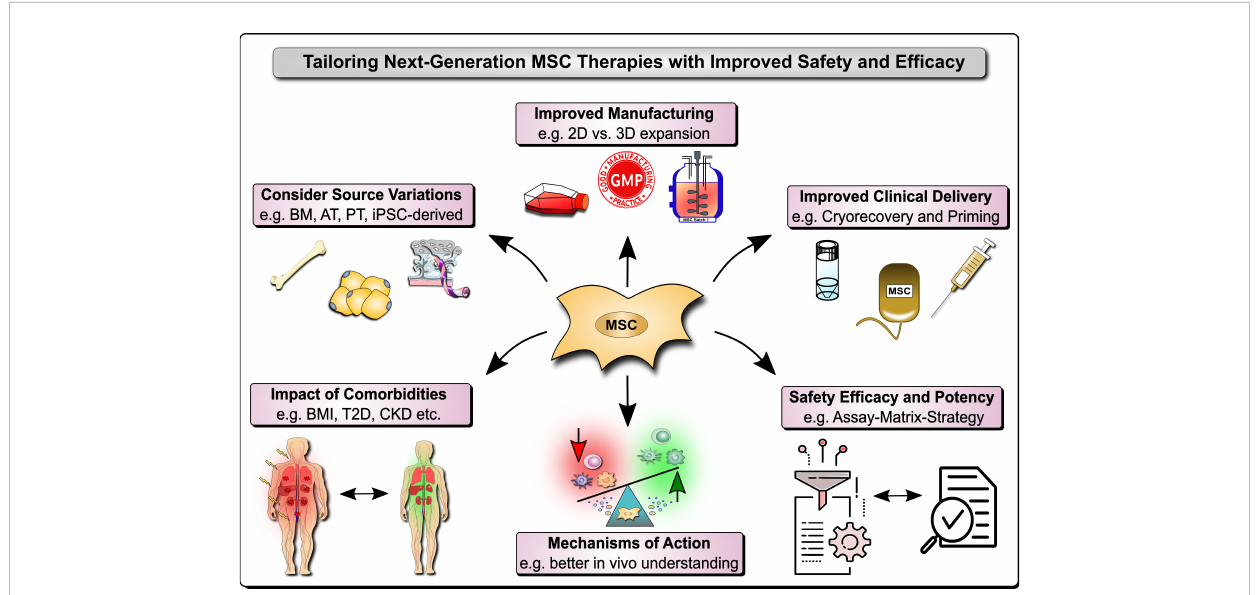
FIGURE 1 Next Generation MSC Therapy Manufacturing, MoA and Potency Analysis. Next-generation MSC therapy improvements to safety and ef fi cacy include among others: 1) Considerations on variations in the MSC source material, e.g. typically including bone marrow (BM), adipose tissue (AT), perinatal tissue (PT), and induced pluripotent stem cell (iPSC)-derived MSC products; 2) The relevant impact of donor comorbidities, e.g. the role of the body mass index (BMI), obesity, and the typically associated common comorbidities that are increasing in the population, such as type 2 diabetes